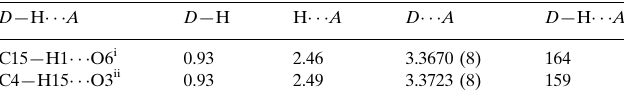
Hydrogen-bond geometry (A˚ , (cid:1)